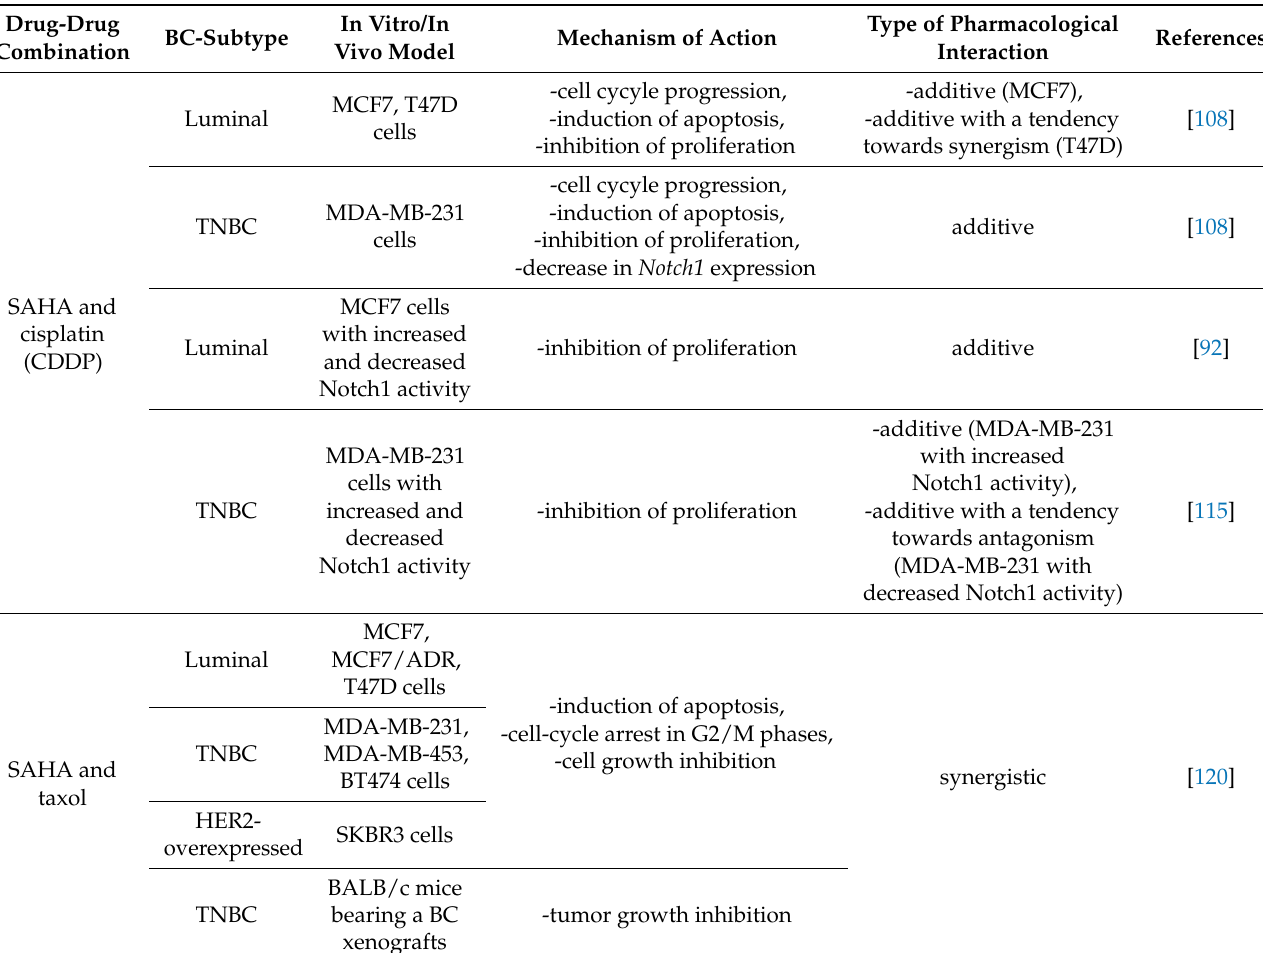
Table 3. Mechanism of action of vorinostat (SAHA) and other anticancer drugs in combination in in vitro and in vivo breast cancer (BC) pre-clinical settings (BC- breast cancer, BZ- bortezomib, CAM- clarithromycin, CDDP- cisplatin, DNA- deoxyribonucleic acid, EGCG- epigallocatechin-3-gallate, ER- endoplasmic reticulum, HER2-human epidermal growth factor receptor 2, MK-0457- tozasertib, NaB- sodium butyrate, PAX- paclitxel, TNBC- triple negative breast cancer, TRAIL- tumor necrosis factor related apoptosis inducing